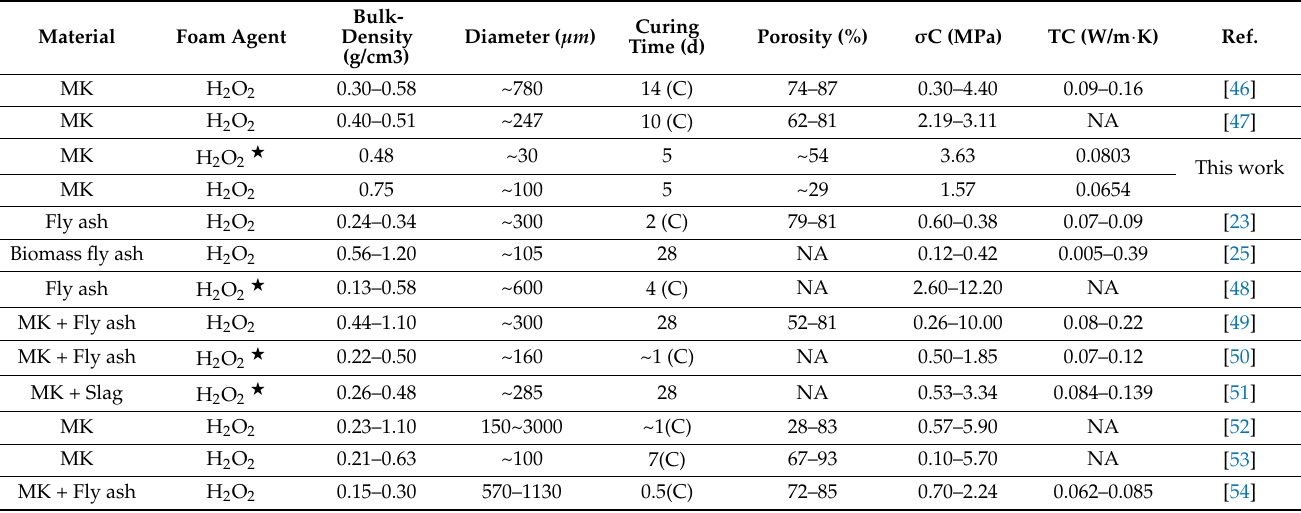
Table 2. Comparative summary of thermo-physical and mechanical properties of GP